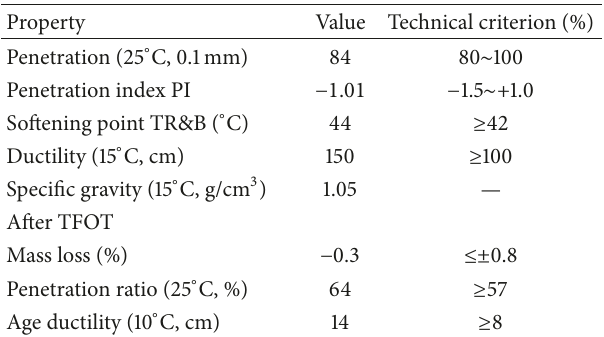
Table 1: Properties of neat asphalt.